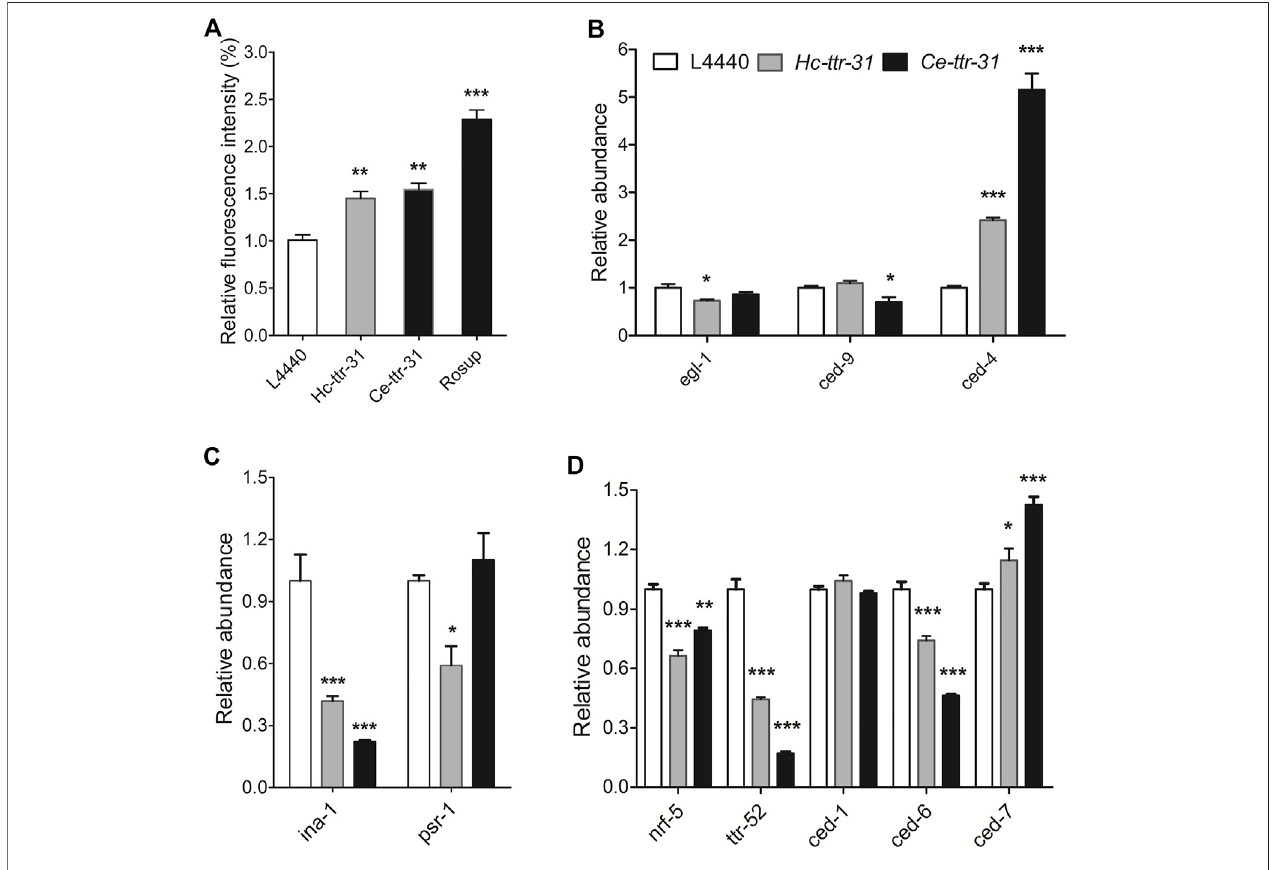
FIGURE 7 | Effect of ttr-31 knockdown on the apoptotic signalling pathway in Caenorhabditis elegans . (A) Relative levels ofreactive oxygen species (ROS) in RNA interference (RNAi)-treated worms, negative and positive (Rosup) controls are shown. (B – D) Transcriptional levels of genes involved in apoptotic signalling pathways in RNAi-treated C. elegans worms. ced-4 : cell death abnormal 4 , egl-1 : egg-laying defective-1 , ina-1 : integrin- α , nrf-5 : nose resistant to fl uoxetine 5 , psr-1 : phosphatidyl serine receptor-1 . * p < 0.05; ** p < 0.01; *** p < 0.001.